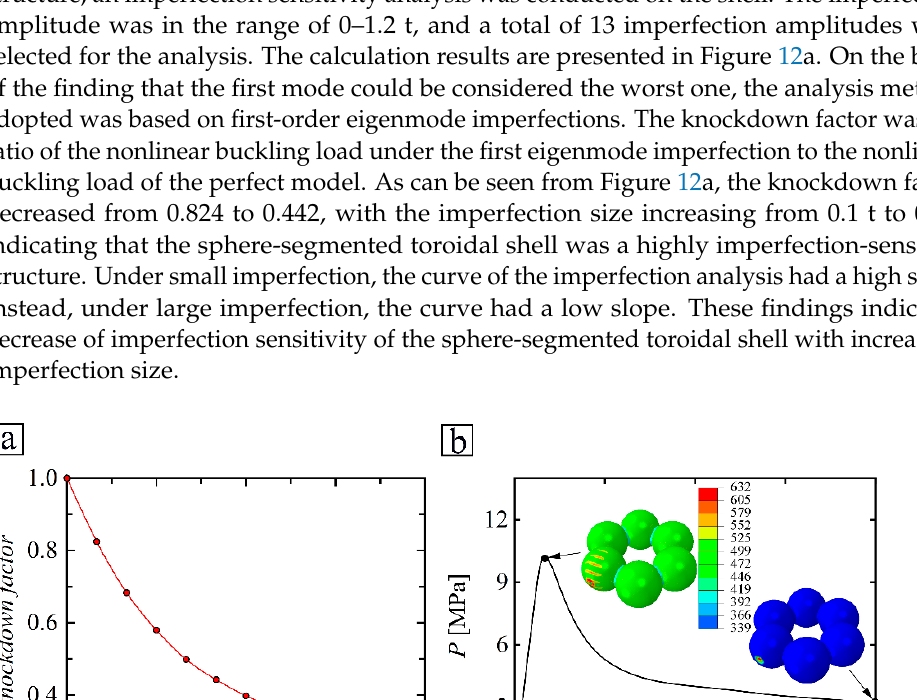
Table 4. Post-buckling modes and nonlinear buckling loads of sphere-segmented toroidal shells (the results correspond to the data in Table 2).